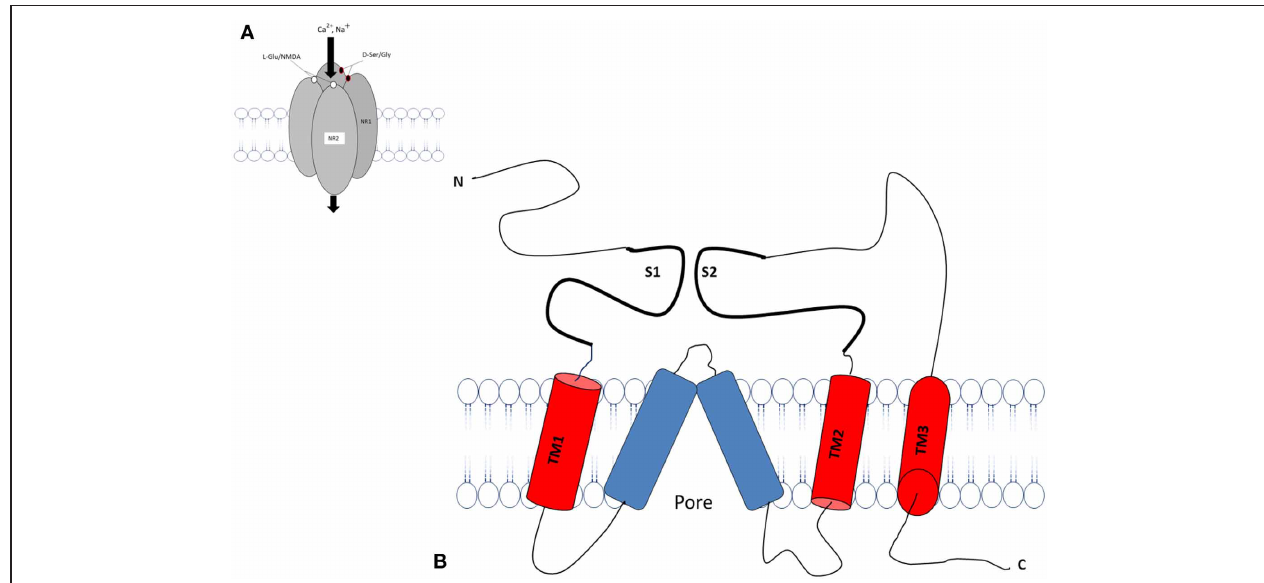
FIGURE 2 | Schematic diagram of an individual subunit of iGlu receptor. (A) Proposed membrane topology of an individual iGluR subunit (NR1/NR2). (B) The ligand-binding region in the iGluR is formed by two separate extra cellular loops containing the S1 and S2 domains. There are three hydrophobic trans membrane domains, TM1, TM2, and TM3 which fully span the